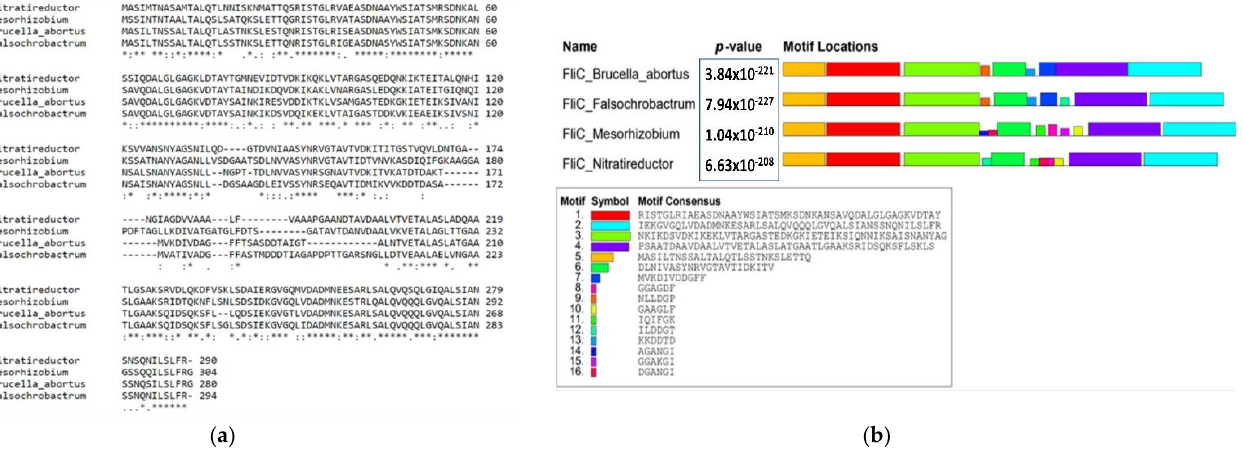
Figure 4. Bacterial FliC amino-acid sequence analysis. ( a ) Multiple alignments of sequences of the FliC protein of Brucella abortus (Q2YJF1) against the FliC protein of Falsochrobactrum sp. HN4 (A0A316J970), Mesorhizobium sp. UASWS1009 (A0A1C2EA77) and Nitratireductor pacificus pht-3B (K2M4Y7) ( b ). There are 16 conserved motifs in relation to the fliC gene present in the abovementioned species. Bioinformatics tool used: http://meme-suite.org (accessed on 15 November 2021).